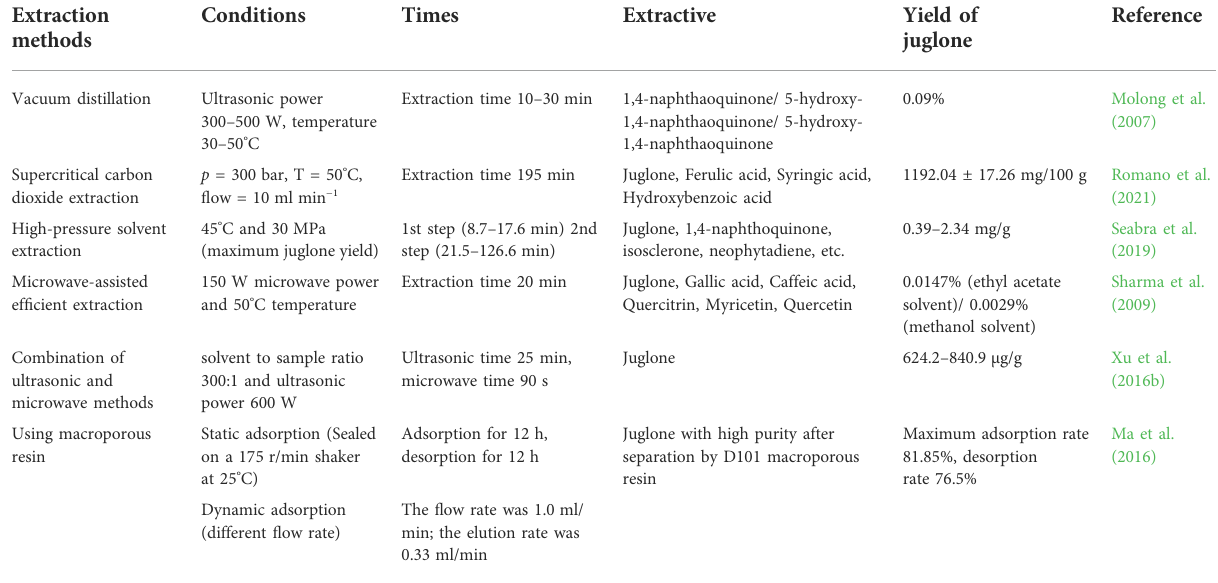
TABLE 1 The conditions and effects of different extraction